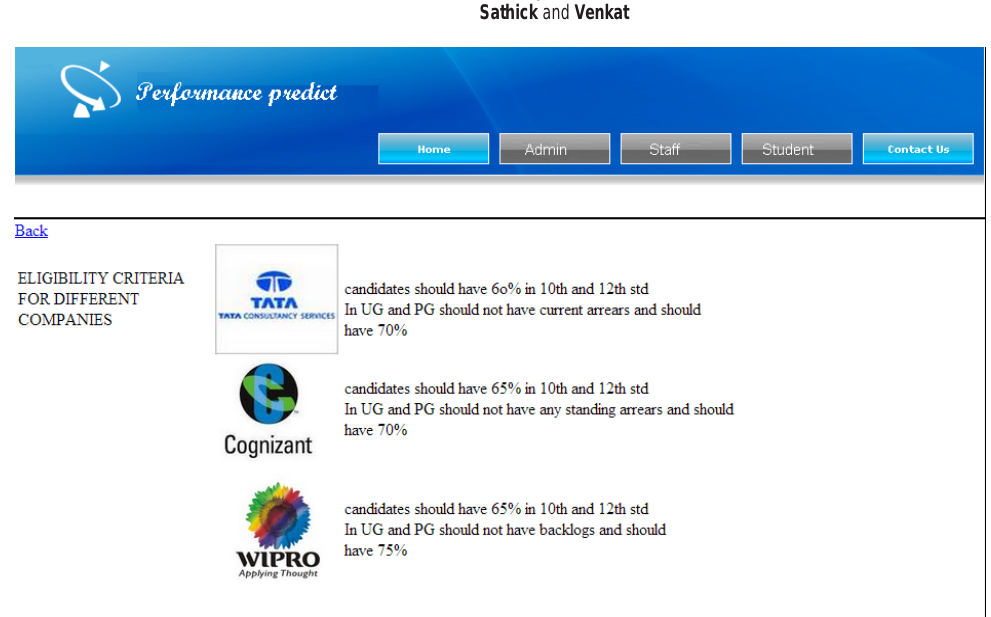
Figure 9. Placement criteria.